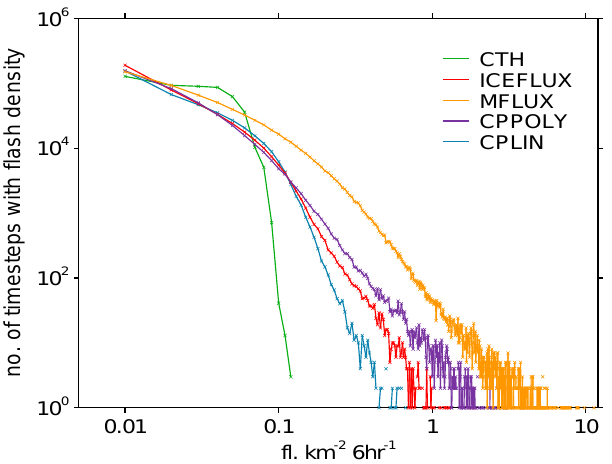
Figure 5. Histograms of 6-hourly flash density in the year 2011 for each parametrisation. Bin size is 0.02fl.km − 2 6h − 1 . The total number of time steps represented by each curve is the same. Grid cells from the full global region are used ( ± 90 ◦